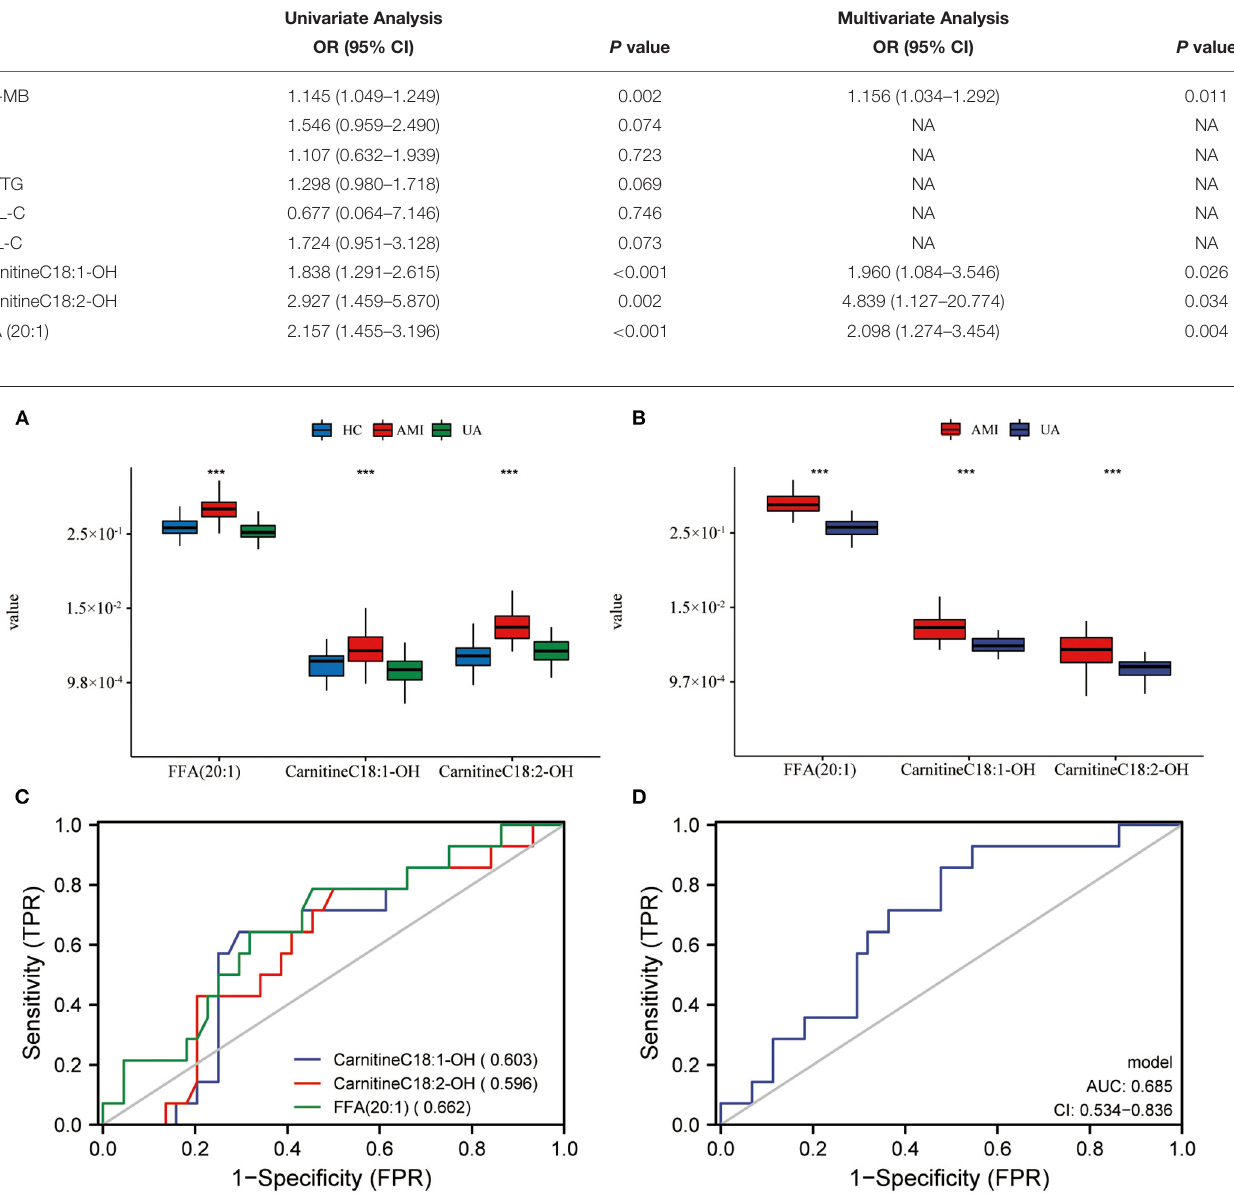
AMI group and the UA group, of which 25 differential lipid metabolites were common between the AMI group and the HC group, and mainly included CAR, FFA, PC and TG.